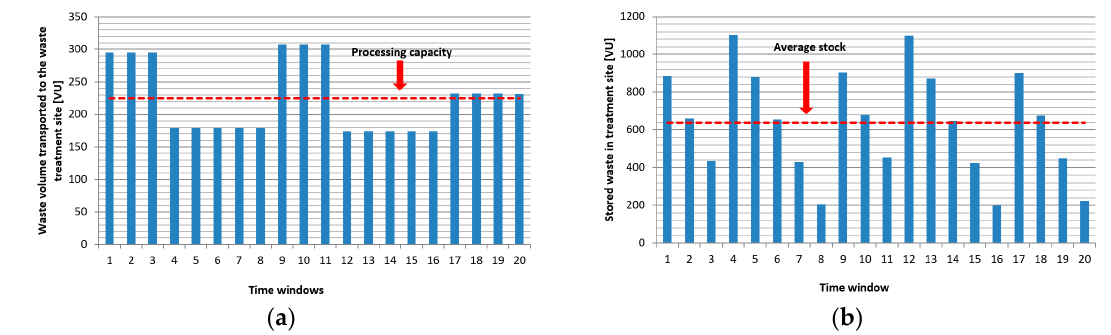
Figure 14. ( a ) Average waste volume between two supply transported to the waste treatment site in Scenario 2. The waste supply is not synchronized with the processing capacity, because the supplied volume of waste increased the required amount in the time windows 1 to 3, 9, to 11 and 17 to 20, while not reaching the required amount in time windows 4 to 8 and 12 to 16; ( b ) Waste inventory at the treatment site (average = 639 VU, max = 1105